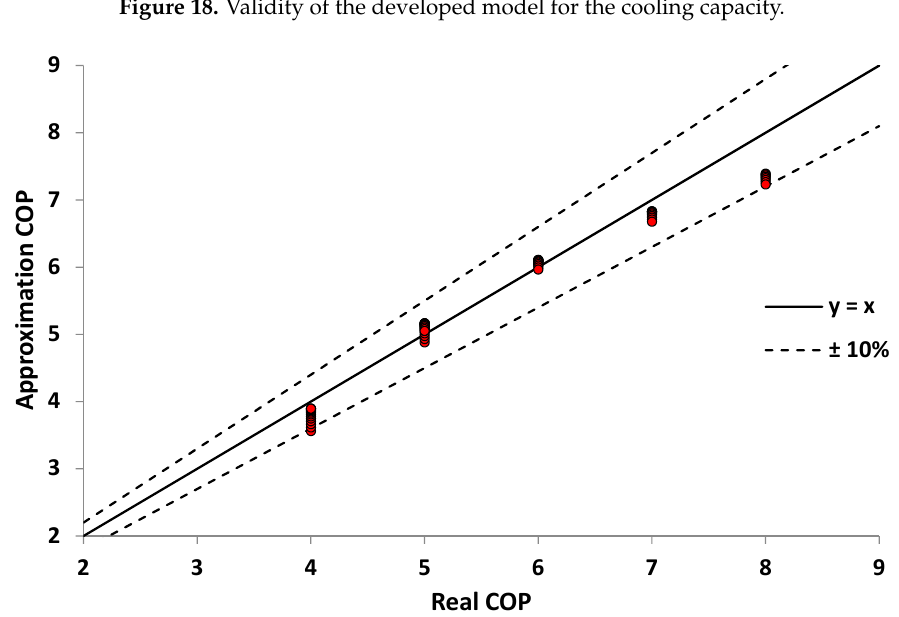
Figure 18. Validity of the developed model for the cooling capacity. Appl. Sci. 2018 , 8 , x FOR PEER REVIEW